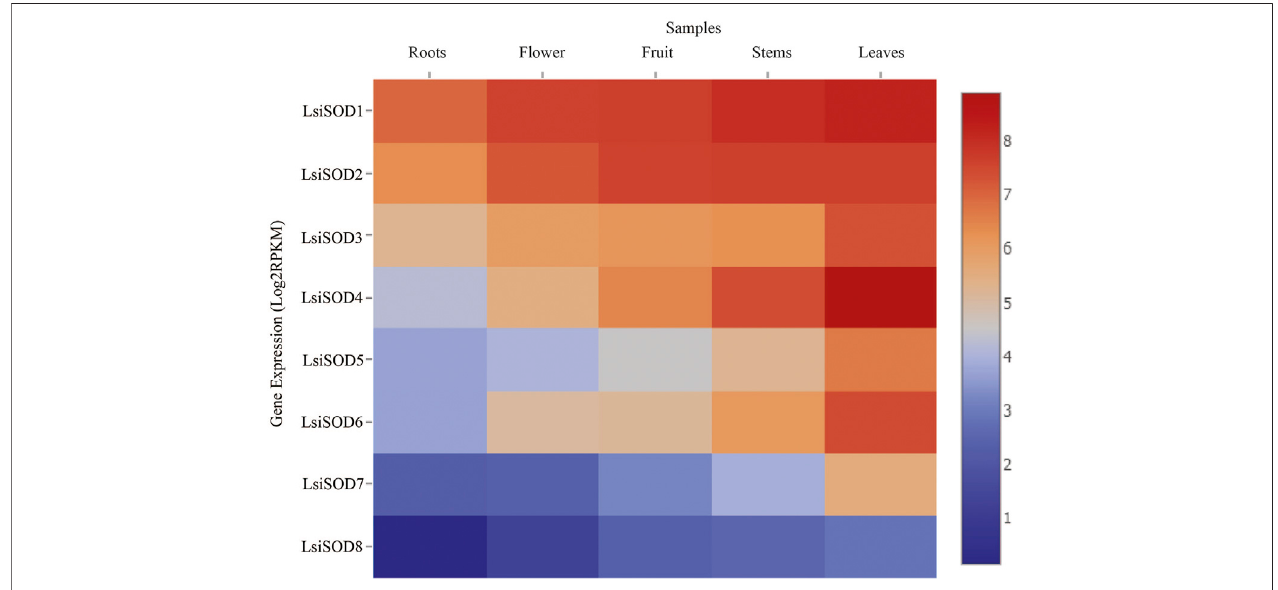
FIGURE 10 | Relative expression pro fi les of SOD genes of fi ve species in Cucurbitaceae family during different developmental stages. The FPKMs calculated by RNA-seq data are shown as a heat map. The color scale is shown at the side of the heat map re fl ecting the higher and lower relative abundance in each tissue.